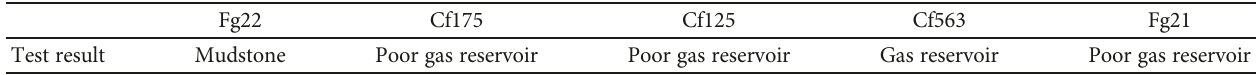
Figure 10: Time – slice of P-wave dispersion gradient along the fi rst set sand of T x 4 member. Inversion results show that the west and the 3 southeast of the area is the favorable zone of gas reservoirs for the high value of P-wave dispersion gradient. Table 2: Logging results of the fi rst set sand of T x 4 3